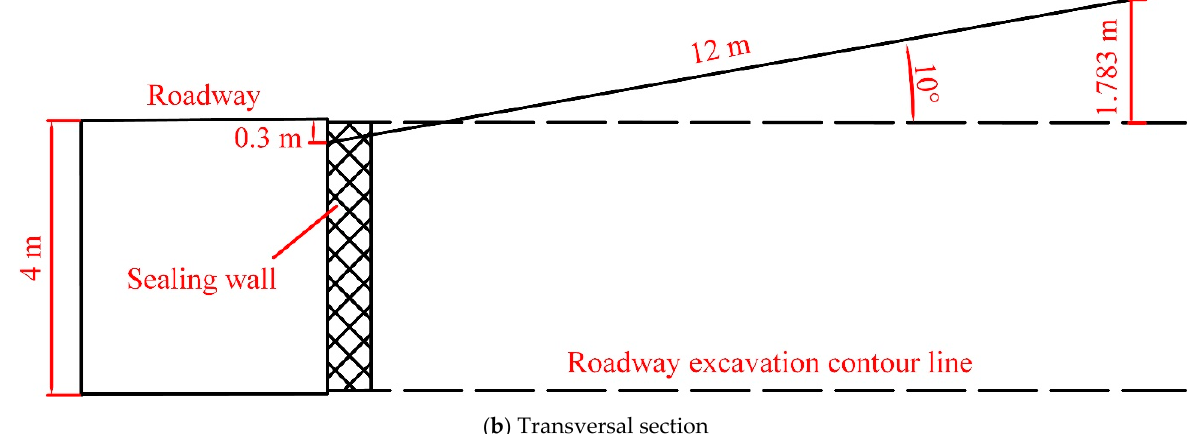
Figure 11. Schematic diagram of advanced grouting construction.